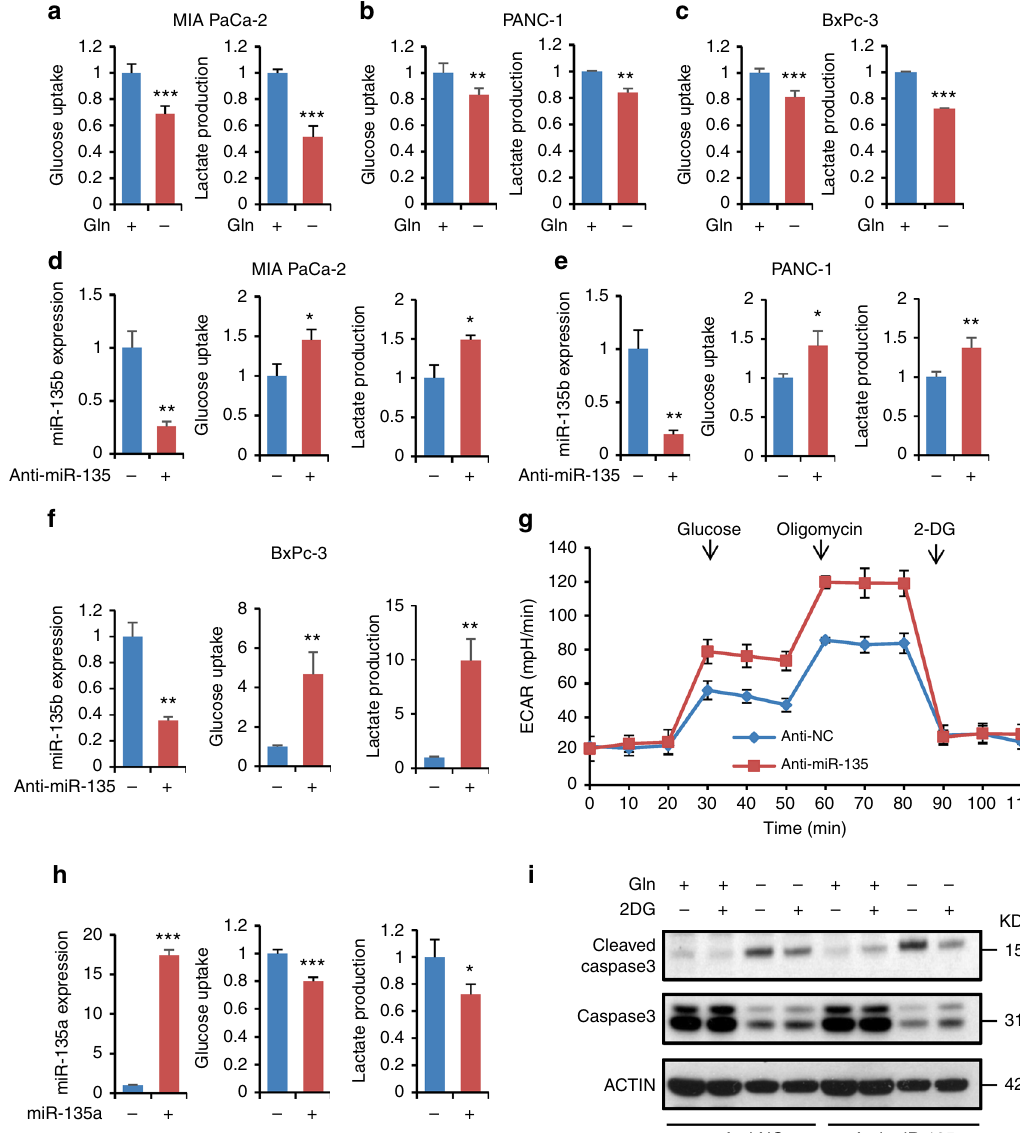
Fig. 4 miR-135 suppresses aerobic glycolysis. a MIA PaCa-2 cells were cultured in complete medium or glutamine-free medium for 24h followed by glucose uptake and lactate production measurements using the Nova Biopro fi le 100 analyzer. Metabolite levels per cell were normalized to control. Each value represents the mean±SD in three independent experiments. *** p < 0.001, Student ’ s t test. b , c PANC-1 cells ( b ) and BxPc-3 cells ( c ) were cultured in complete medium or glutamine-free medium for 24h followed by glucose uptake and lactate production measurements using the Nova Biopro fi le 100 analyzer. Metabolite levels per cell were normalized to control. Each value represents the mean±SD in four independent experiments. ** p <0.01, *** p <0.001, Student ’ s t test. d − f Relative miR-135b expression in MIA PaCa-2 cells ( d ), PANC-1 ( e ), and BxPc-3 ( f ) expressing anti-NC or anti-miR-135 was assessed by qPCR. Cells were cultured in complete medium for 24h followed by glucose uptake and lactate production measurements using the Nova Biopro fi le 100 analyzer. Each value represents the mean±SD in three independent experiments. * p <0.05, ** p < 0.01, Student ’ s t test. g ECAR was measured in MIA PaCa-2 cells expressing anti-NC or anti-miR-135 using the XF-24 Seahorse system. Each value represents the mean±SD in fi ve independent experiments. h Scramble and miR-135a expressing MIA PaCa-2 cells were cultured in complete medium for 24h followed by glucose uptake and lactate production measurements using the Nova Biopro fi le 100 analyzer. miR-135 expression was assessed by qPCR. For qPCR, each value represents the mean±SD in four independent experiments. *** p <0.001, Student ’ s t test. For glucose uptake and lactate production, each value represents the mean±SD in three independent experiments. * p <0.05, *** p < 0.001, Student ’ s t test. i MIA PaCa-2 cells expressing anti-NC or anti-miR-135 were cultured in complete medium or glutamine-free medium supplemented with 2.5mM 2DG. Cells were lysed and immunoblotting was performed with indicated